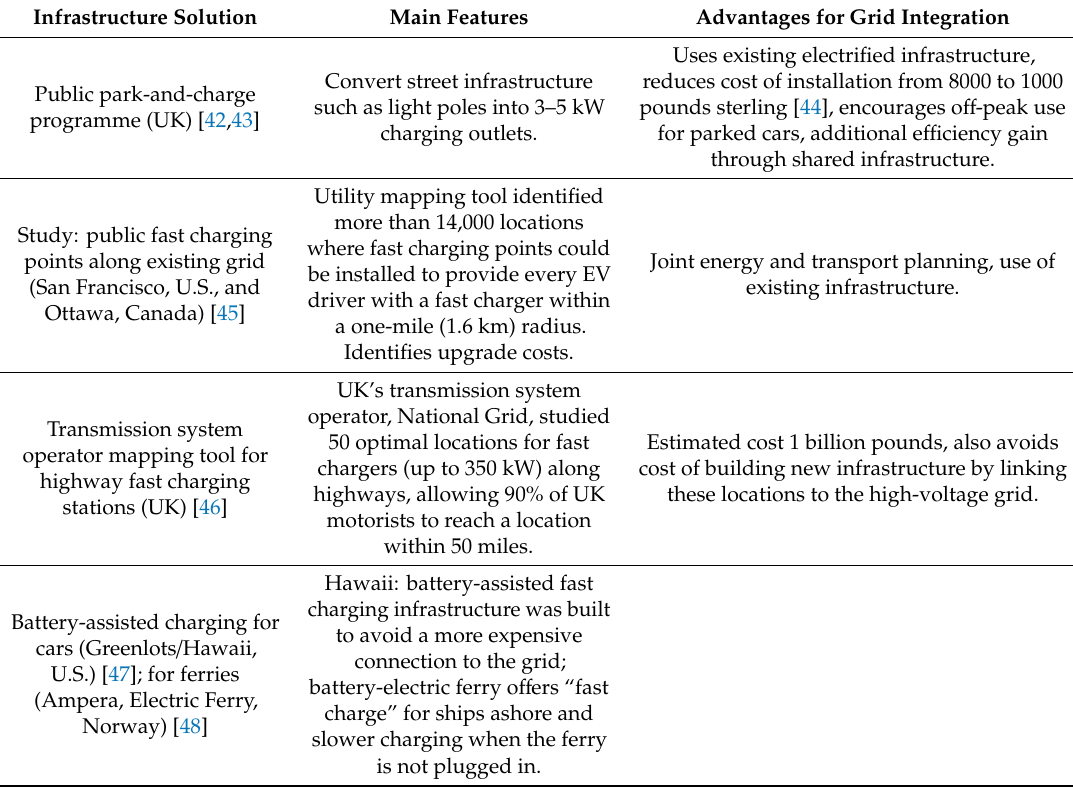
Table 3. Examples for smart infrastructure